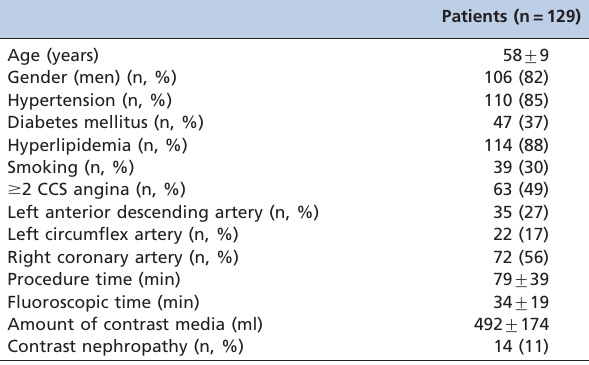
Table 1 - The demographic, angiographic, and procedural characteristics of the patients.